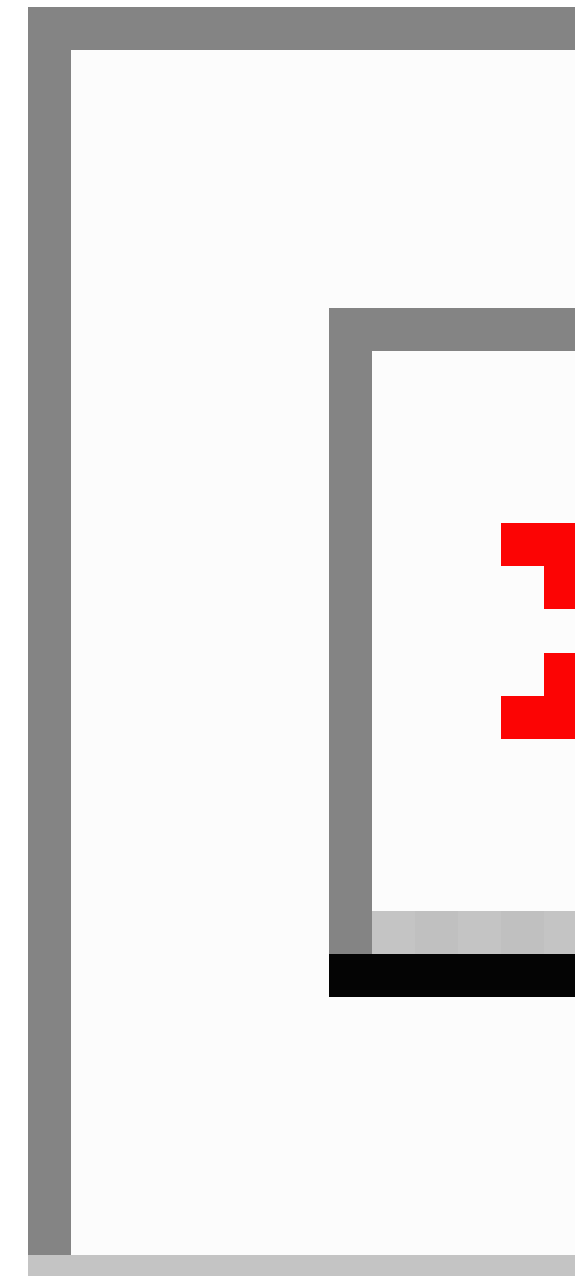
Figure 1. Screenshot of the Psyfit